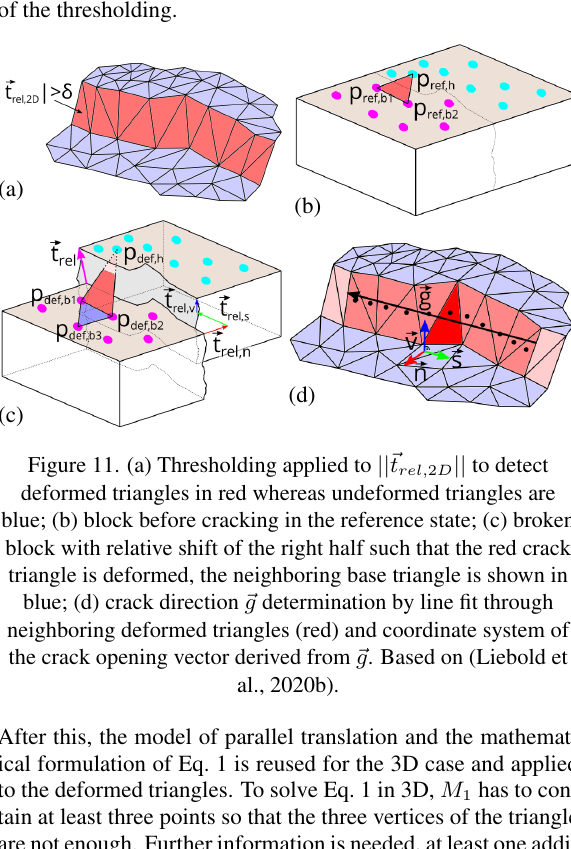
the torsion test example (red: crack normal components, green: shear components, blue: vertical components, scale factor: